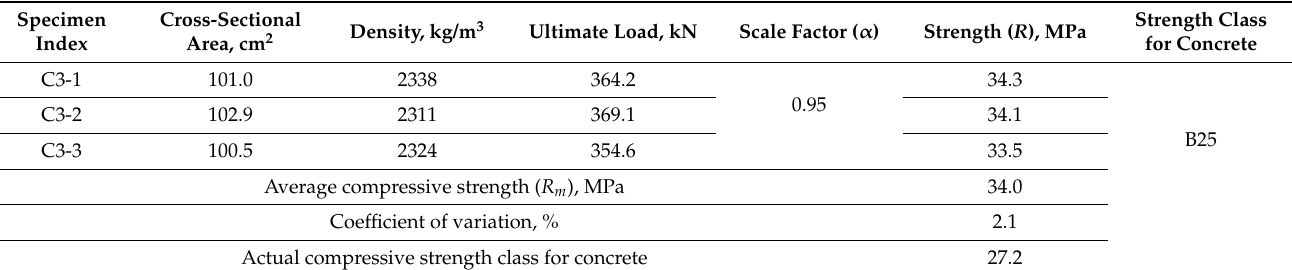
Table 3. Test results for concrete cubes.